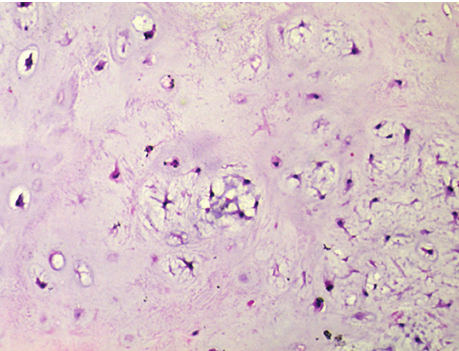
Figure 2: Hypocellular and homogenous appearance of tumor. Tumor cells are small, oval-round shaped (no mitosis and atypia). Hematoxylen Eosin stain ×